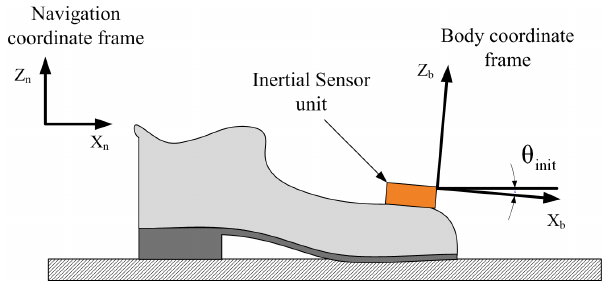
when a foot is on a flat init